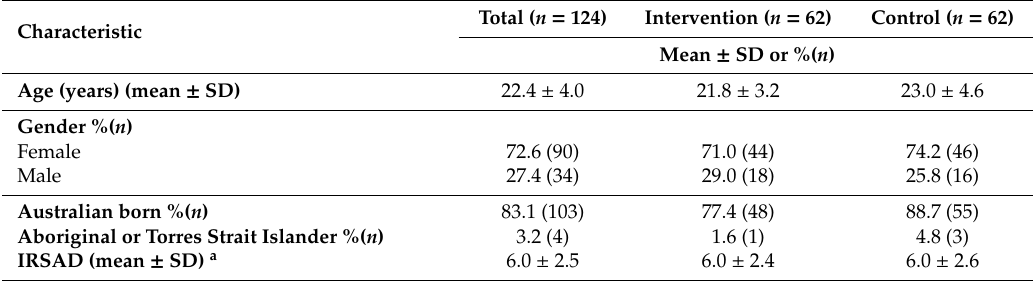
Table 1. Baseline characteristics of young adult university students participating in the EATS pilot randomized controlled trial ( n = 124).